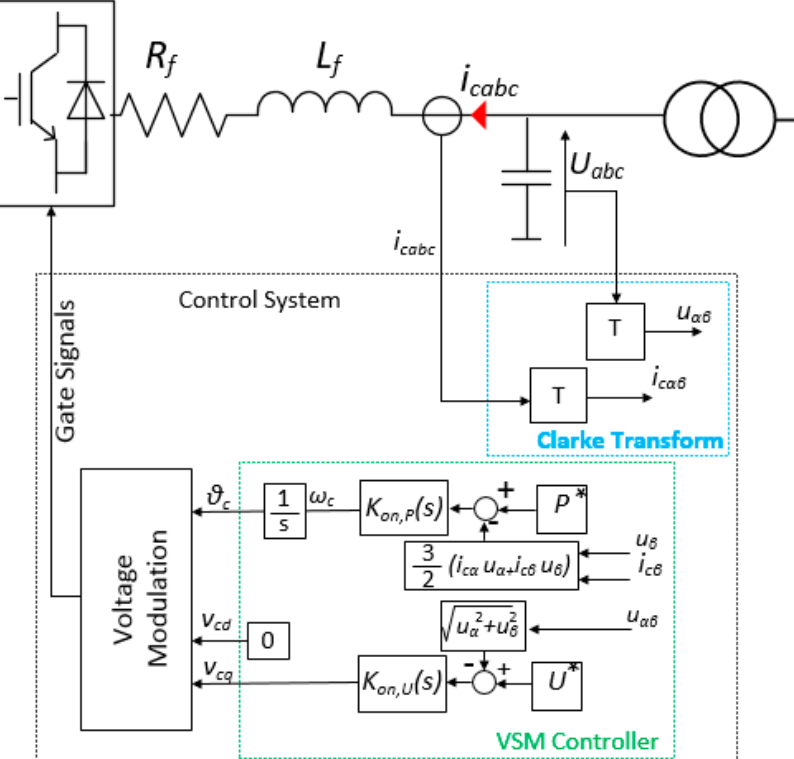
Figure 5. Virtual synchronous machine (VSM) controller diagram.